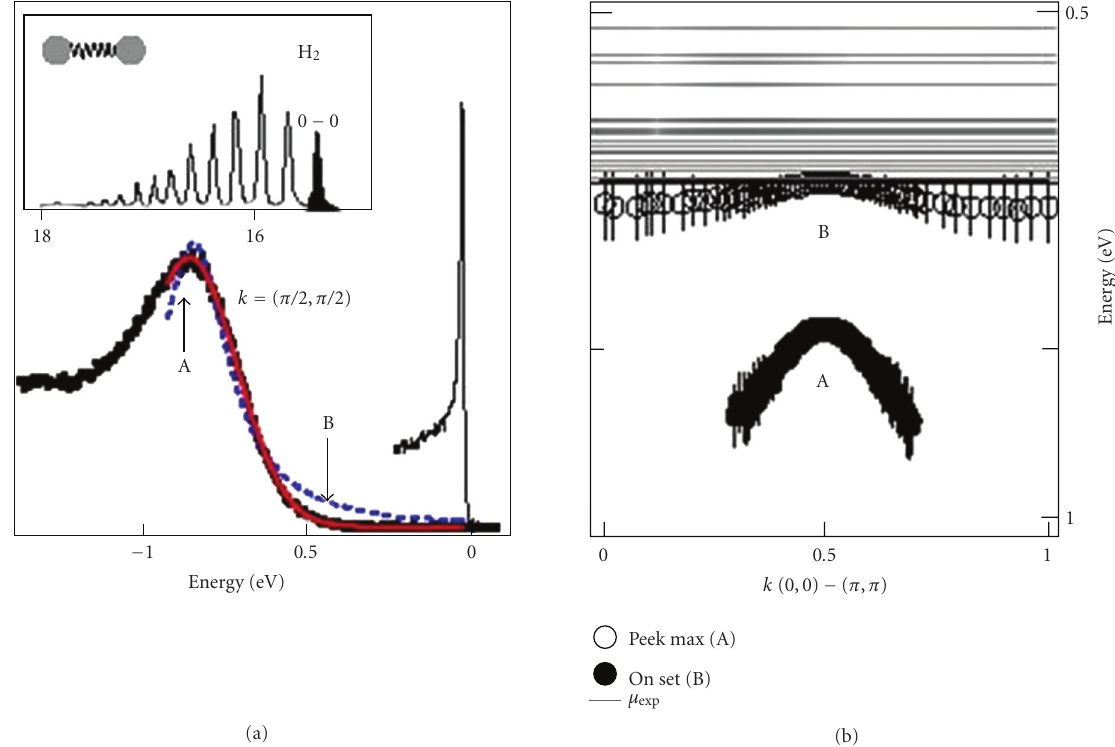
Figure 17: (a) The ARPES spectrum of undoped Ca 2 CuO 2 Cl 2 at k = ( π/ 2, π/ 2). Gaussian shape—solid line, Lorentzian shape—dashed line. (b) Dispersion of the polaronic band—A—and of the quasiparticle band—B—along the nodal direction. Horizontal lines are the chemical potentials for a large number of samples. From